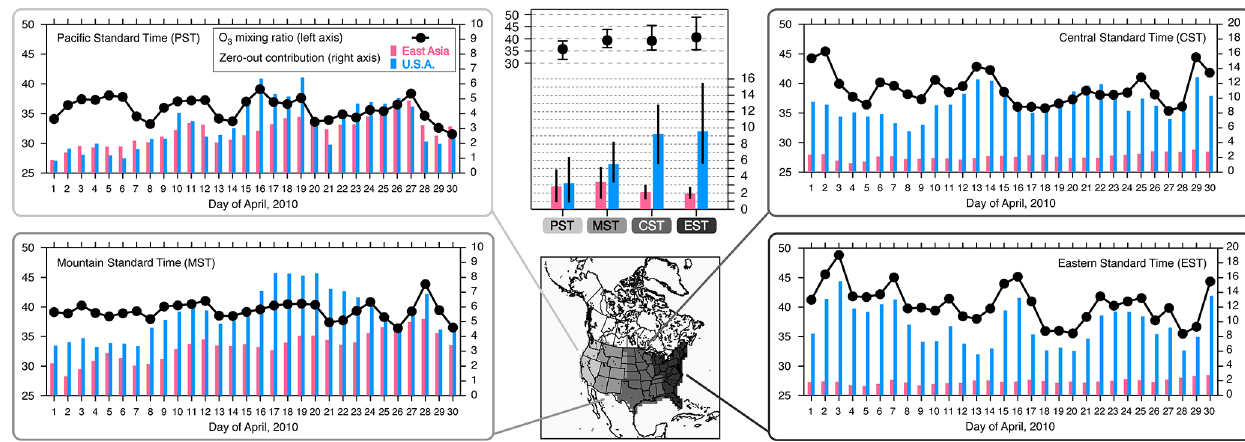
Figure 4. Daily and monthly averaged O 3 mixing ratio (left axis; black circles and thick lines) and zero-out contribution from the US and east Asia (right axis; light blue and light red bars, respectively) summarized over four time zones of Pacific, Mountain, Central, and Eastern Standard Time (PST, MST, CST, and EST) in the US. The units of the left and right axes are ppbv. On a monthly average basis (center panel), whiskers indicates daily minimum and maximum. Note that the axis of zero-out contributions is different in the left (PST and MST) and right panels (CST and EST).